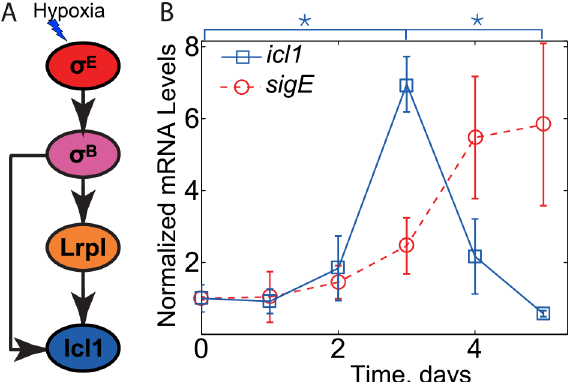
Fig 1. Non-monotonic induction of icl1 . (A) Structure of icl1 transcriptional regulation network. The central metabolism gene icl1 was previously thought to be solely controlled by a simple feedforward network under hypoxic conditions. Arrows represent positive transcriptional regulation. (B) Expression measurements for icl1 and the accessory sigma factor sigE mRNA (data from [12]). Three independent experiments were performed, and the means (error bars are ± standard deviations) are reported, normalized to the mean value of the first data point. While sigE copy number is increasing, icl1 peaks at day 3 and decreases after that. ( * p (cid:1)